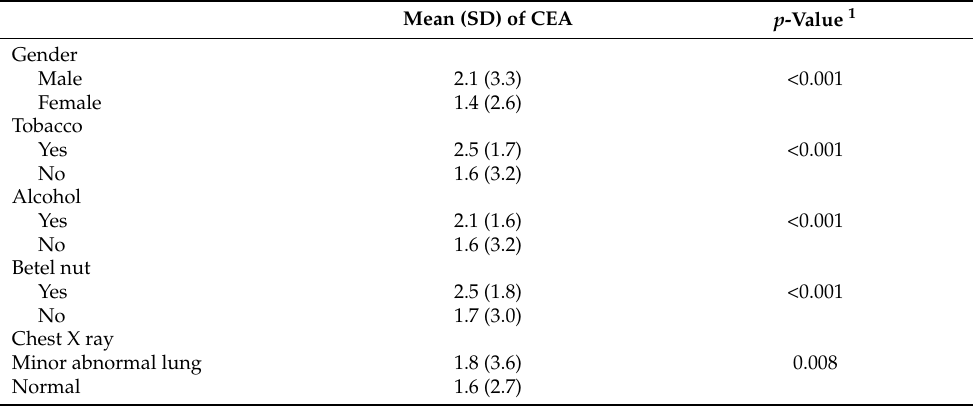
Table 3. Carcinoembryonic antigen (CEA) levels (ng/mL) in different groups: gender, tobacco, alcohol, betel nut, and chest X-ray finding. Mean (SD) of CEA p -Value